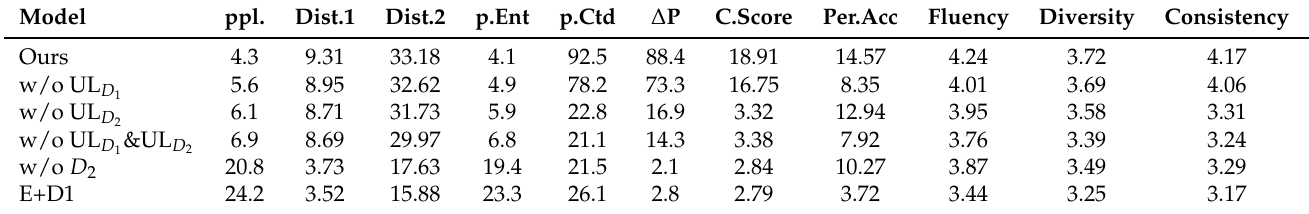
Table 5. Ablation study results of PersonaChat dataset.